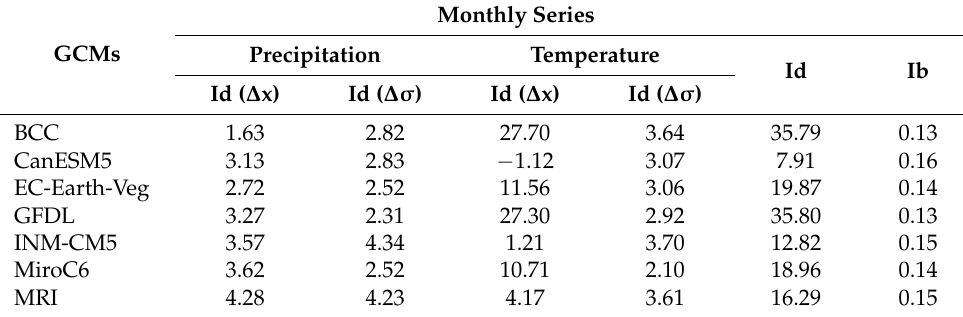
Table 3. Id indicator for each